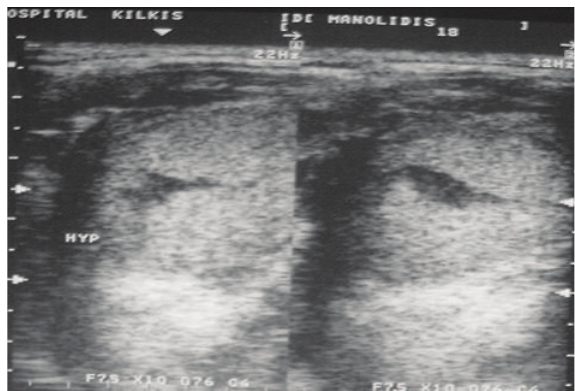
Figure 9: The (ECHO) ultrasonic scan of the area showing a sizeable infrasonic formation with distinct boundaries.